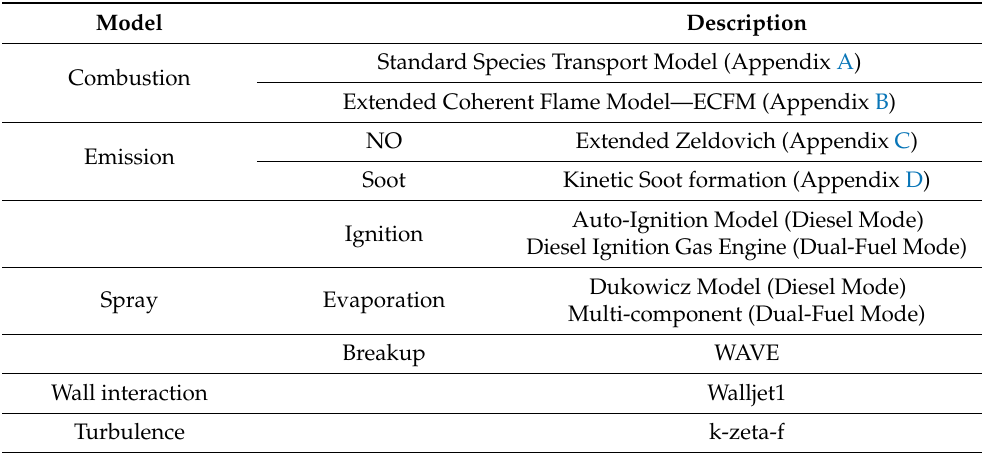
Table 2. The summary of the numerical